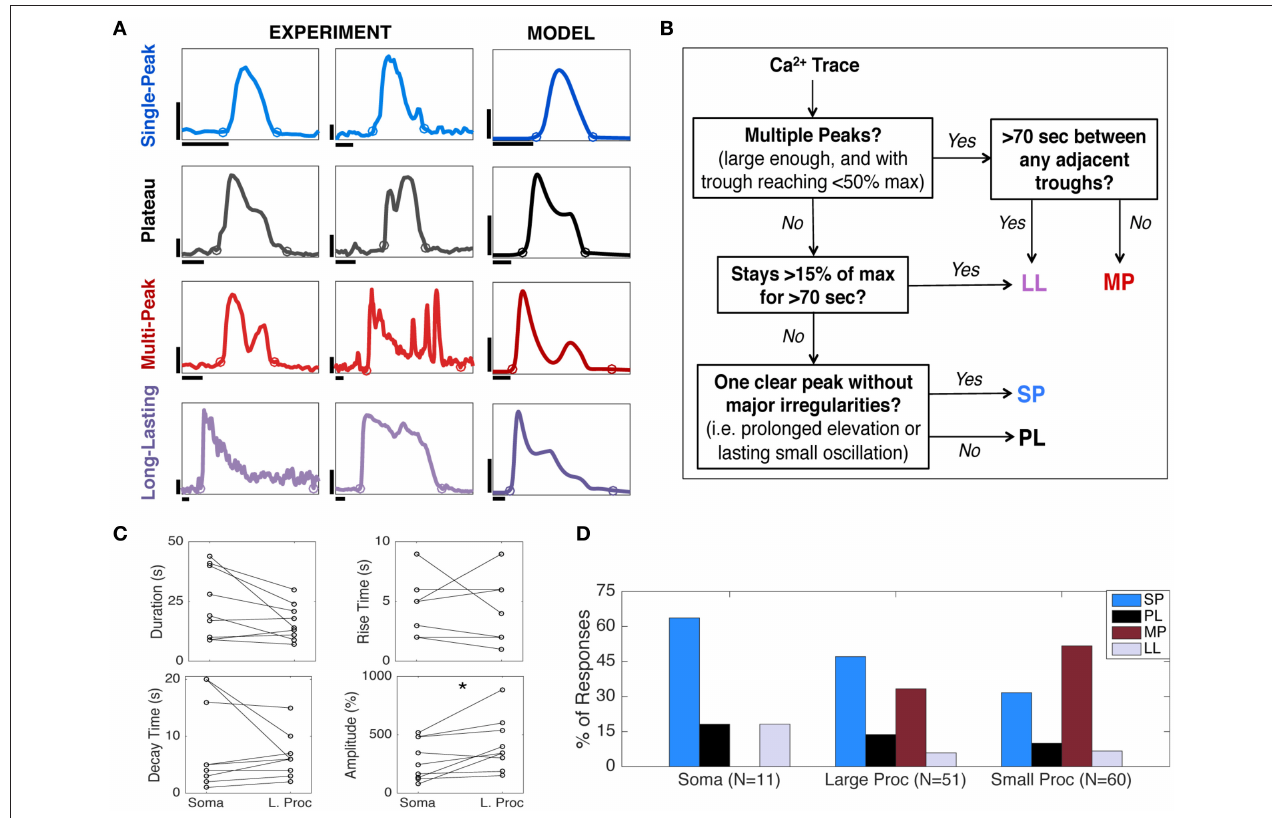
FIGURE 2 | Astrocyte Ca 2 + response types and kinetics. (A) Four categories of astrocyte Ca 2 + responses observed experimentally (first and second columns) and in the model (third column). Experimental data show astrocyte Ca 2 + responses to a focal application of ATP. Each of the two experimental columns contain one example of each response type to show the variability within each response category. The model traces are chosen to reproduce responses similar to the first column. For parameter values, see Figure 4A . The circles for each trace show the response onset and offset (calculation described in section Materials and Methods). Horizontal scale bars, 10s; vertical scale bars, 100% 1 F/F for the experiment and 0.5 µ M [Ca 2 + ] cyt for the model. (B) Flow chart summarizing the algorithm for Ca 2 + response type categorization (details in section Materials and Methods). (C) The rise times, decay times, durations, and amplitudes of SP responses in the soma and a large process of the same astrocyte ( N = 9, stimulus durations 16–250ms), paired with one another. Only amplitude results were significantly different (* p < 0.05; see text), suggesting that there is more variability in SP kinetics between cells and trials than between astrocyte subcompartments. (D) The distribution of observed Ca 2 + response types varies between the somas, large processes, and small processes ( N = 3 mice, 3 trials per mouse, 3–5 cells per trial, up to 10 ROIs per cell; only responsive cells with minimal spontaneous activity were included here; stimulus durations